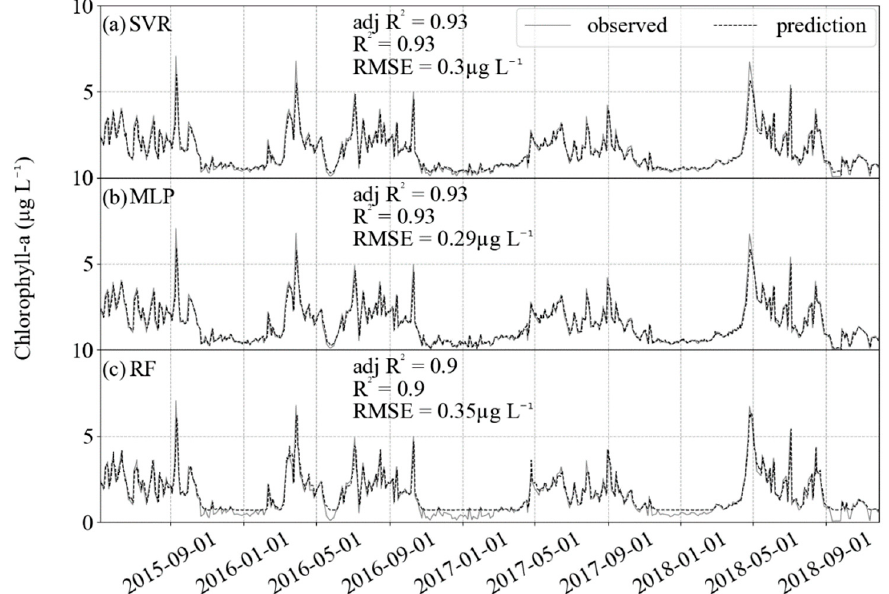
Figure 6. Results of prediction (black dashed) and comparison with the validation dataset (gray solid). For the three algorithms, R 2 is approximately 0.9 and RMSE lower than 0.3 µg L − 1 . ( a ) SVR, ( b ) MLP and ( c ) RF.